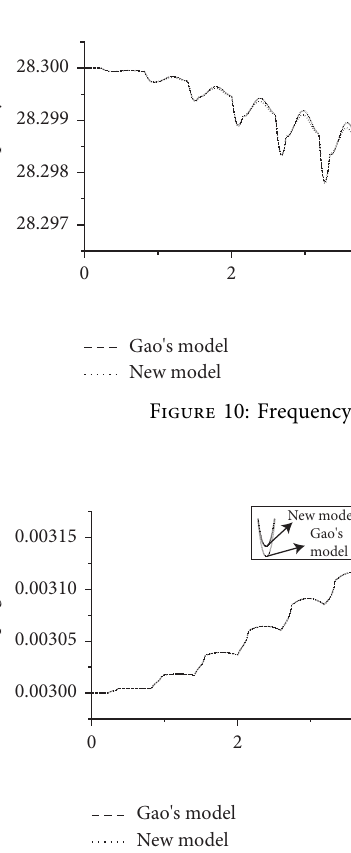
Figure 11: Damping ratio of the system (initial vector